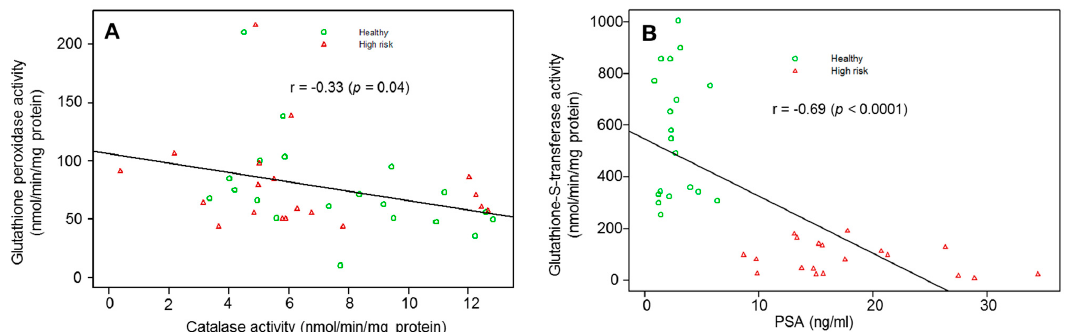
Figure 5. Correlation between ( A ) glutathione peroxidase activity versus catalase activity, ( B ) glutathione S-transferase activity versus PSA in healthy controls and high-risk subjects for prostate cancer. The association was estimated using the Pearson correlation coefficient (r) and illustrated using a scatter plot. p -value < 0.05 is considered significant.